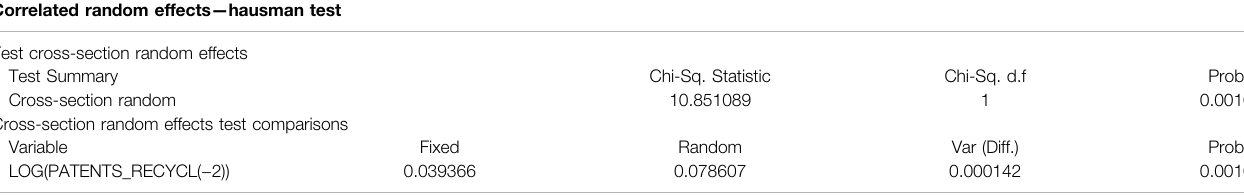
TABLE 5 | Hausman test for Random Effects Model.